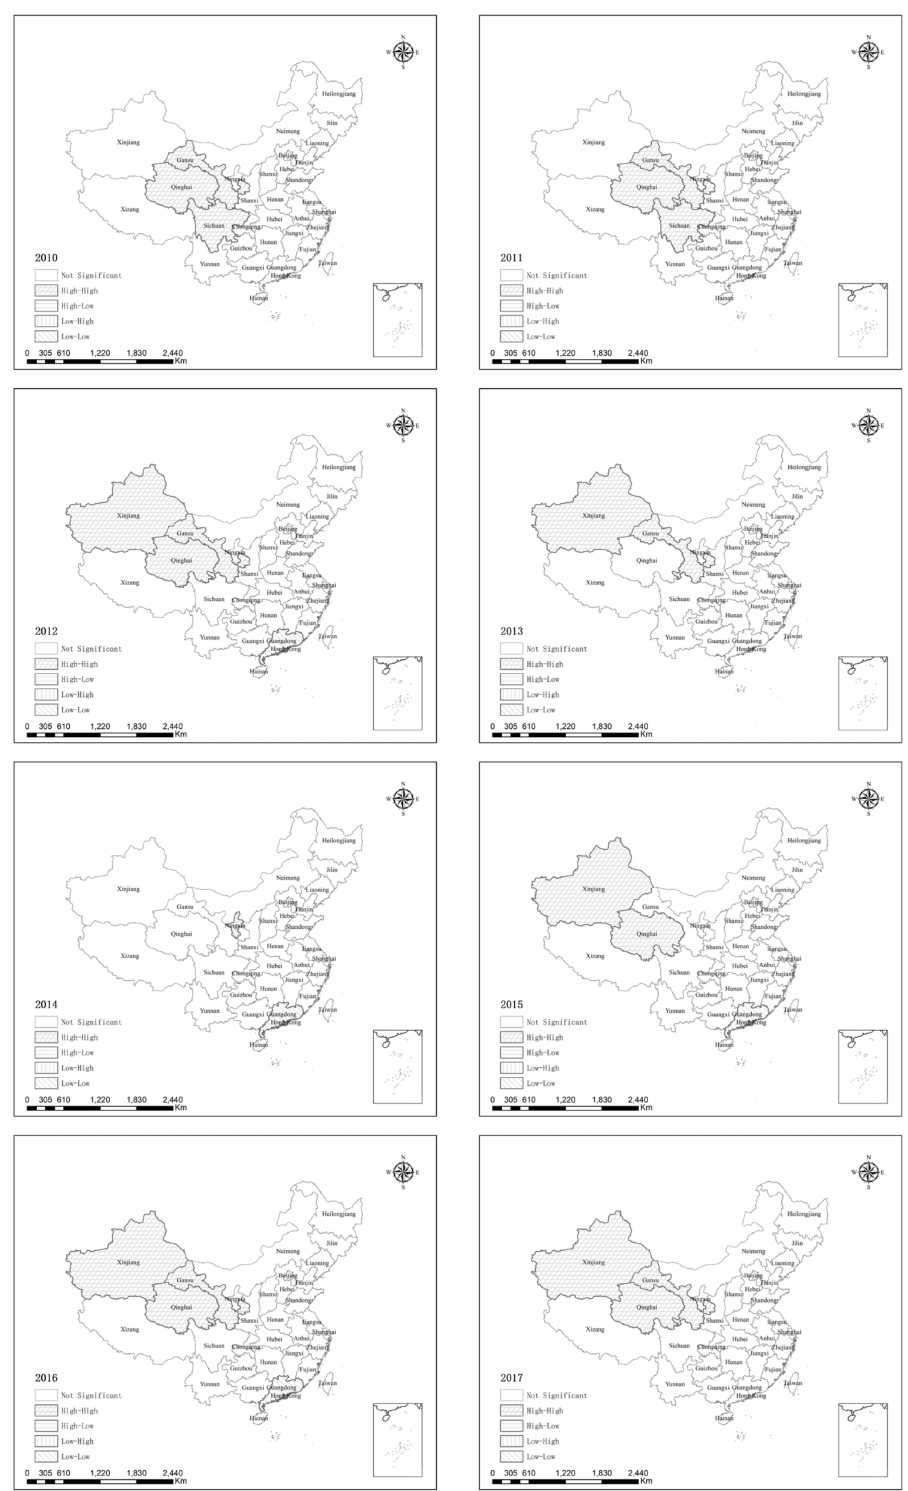
Figure 7. Moran scatter diagram of coordinated development level from 2010 to